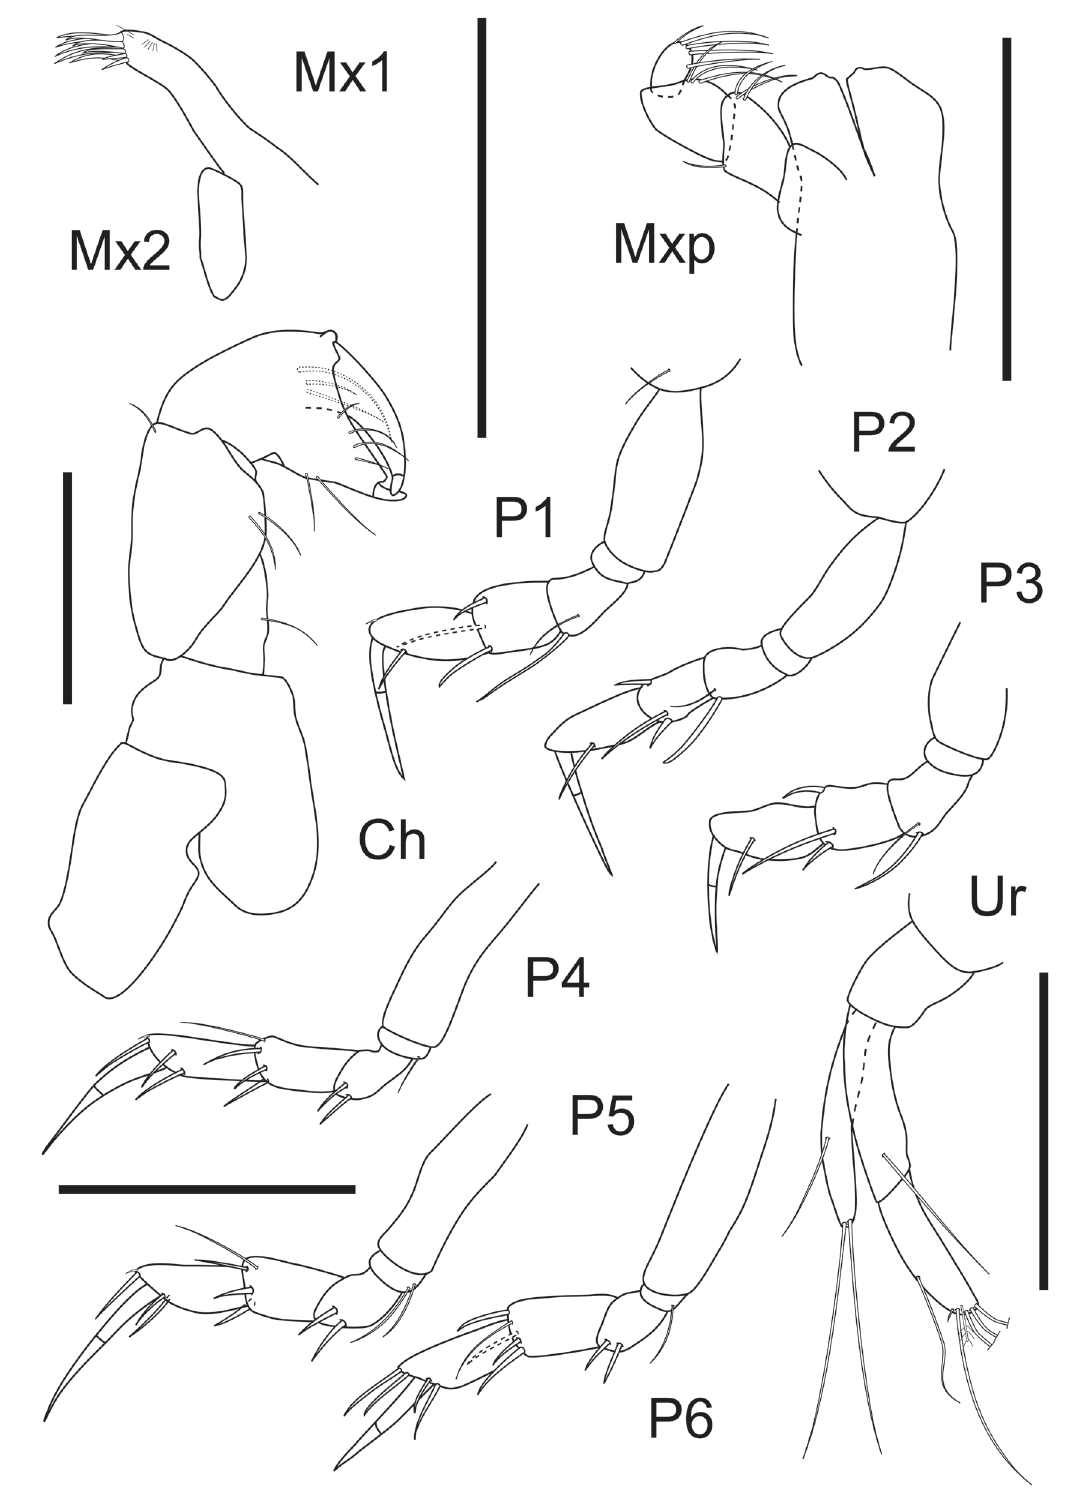
Fig. 3. Filitanais elongatus sp. nov., holotype, ♀ (MNRJ 24443), length 1.9 mm. Abbreviations: Mx1 = maxilulle; Mx2 = maxilla; Mxp = maxilliped; Che = cheliped; P1 = pereopod 1; P2 = pereopod 2; P3 = pereopod 3; P4 = pereopod 4; P5 = pereopod 5; P6 = pereopod 6; Ur = uropod. Scale bars = 0.1